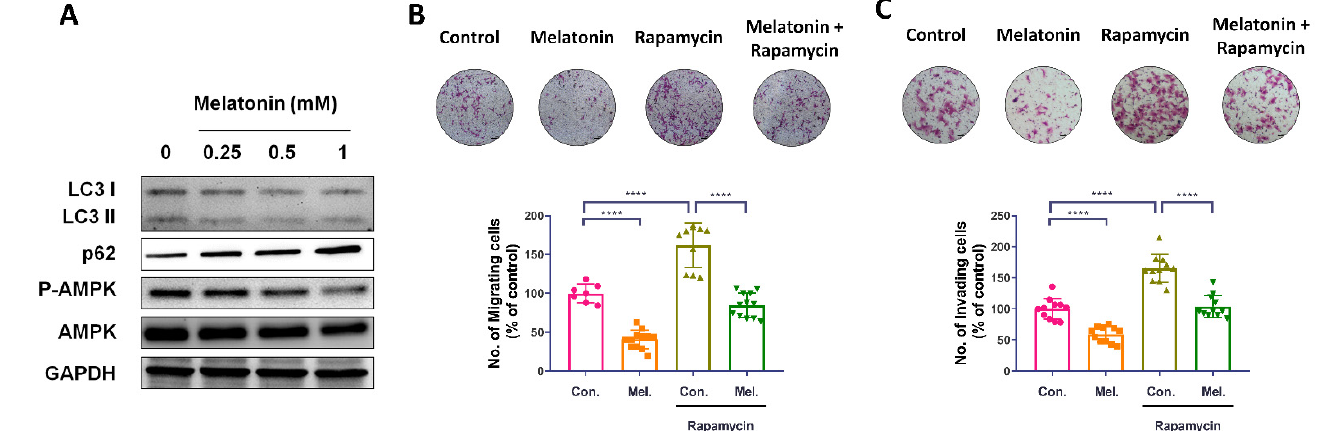
Figure 4. Melatonin-induced inhibition of bladder cell migration was potentiated by autophagy. ( A ) T24 bladder cancer cells, treated with various concentrations of melatonin (0–1 mM) for 24 h, were subjected to analysis of autophagy marker expression. The expression levels of LC3, p62, p-AMPK, and AMPK were determined by Western blot. GAPDH was used as the internal control. ( B , C ) T24 and UM-UC-3 cells were pretreated with rapamycin (1 µ M) for 30 min before incubation with melatonin (1 mM) for 24 h; cell migration was examined with the Transwell assay. Results are expressed as the mean ± SEM. **** p < 0.0001 compared with the control group.